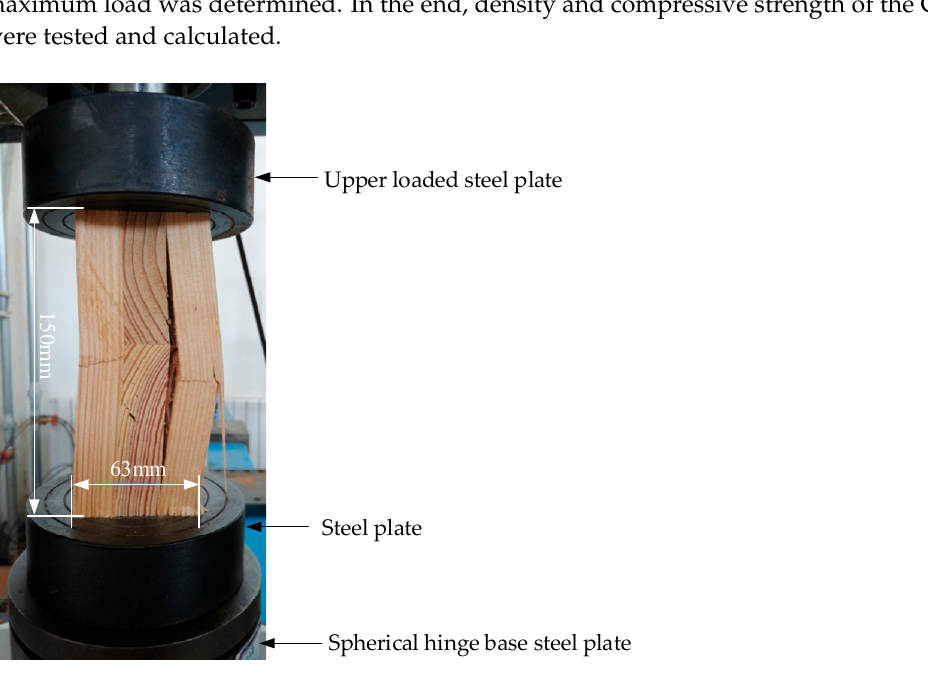
Figure 1. Schematic of CLT compressive strength testing (The figure was taken during the testing progress, the load speed was 3 mm/min, a spherical hinge base steel was used under the specimen).